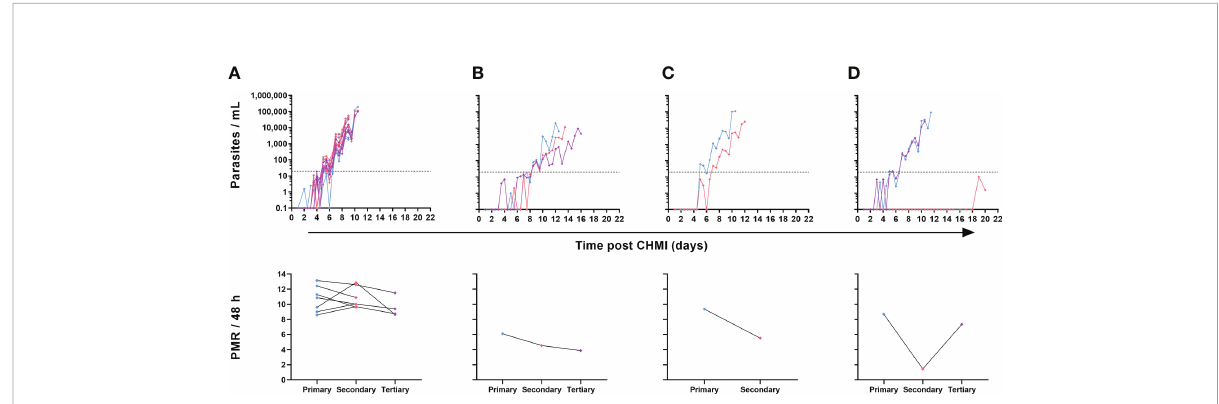
FIGURE 6 Individual variation in parasite growth dynamics of repeated P. falciparum blood-stage CHMI. qPCR data for primary (blue), secondary (pink) and tertiary (purple) CHMI. Parasitaemia is shown over time for each volunteer who underwent more than one CHMI (total n=10). The PMR per 48 hours was modelled from the qPCR data up until the time point of diagnosis for each participant for each CHMI and is shown below the relevant parasite growth graph. (A) Data from participants who showed minimal variation in parasite growth dynamics between each CHMI (n=7 for primary and secondary CHMI, of whom n=4 also underwent tertiary CHMI). (B) One participant showed consistently slower parasite growth with each subsequent CHMI. (C) One participant showed slower parasite growth during secondary CHMI compared to primary but did not undergo a tertiary CHMI. (D) One participant showed completely suppressed parasite growth on secondary CHMI until day C+19 but no change compared to primary upon tertiary